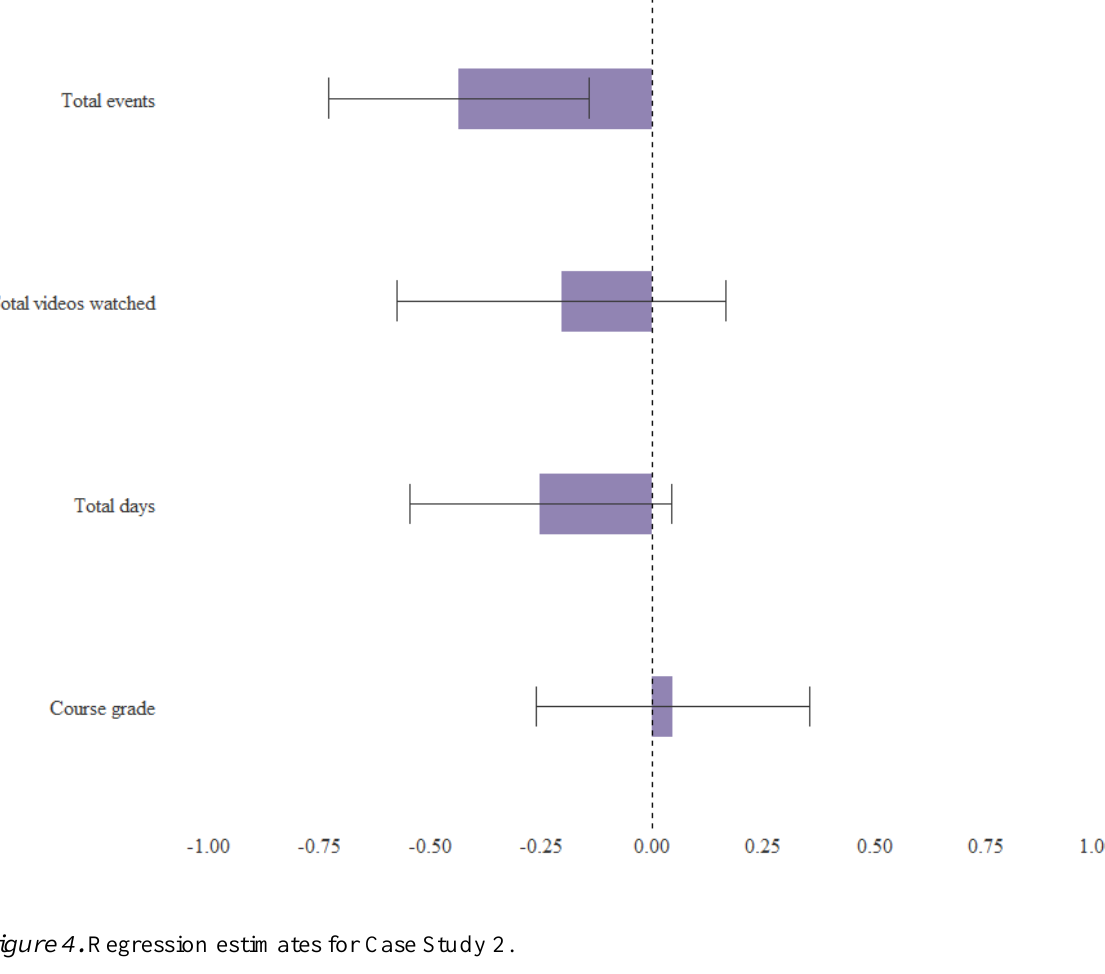
Figure 4. Regression estimates for Case Study